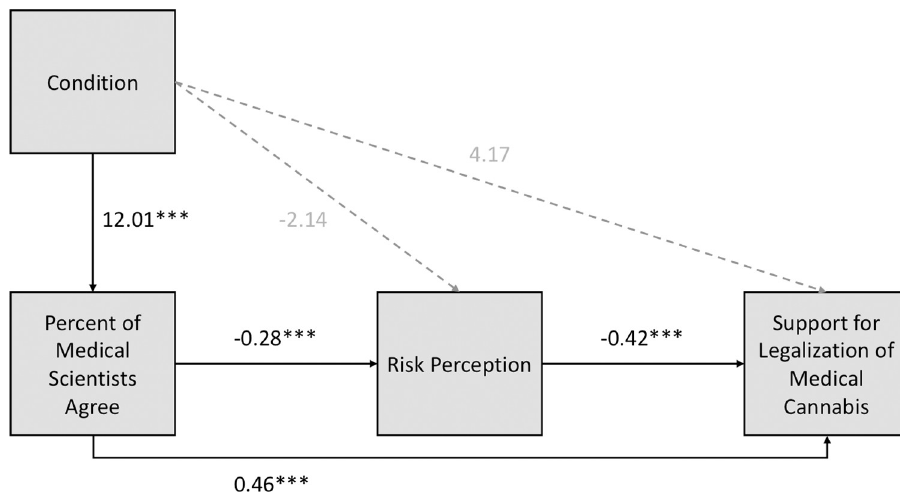
Fig 4. Modified version of the GBM for medical cannabis using the posttest-only data. Note that condition only reflects the descriptive norm/authority message versus the control message and does not include the evidence message.